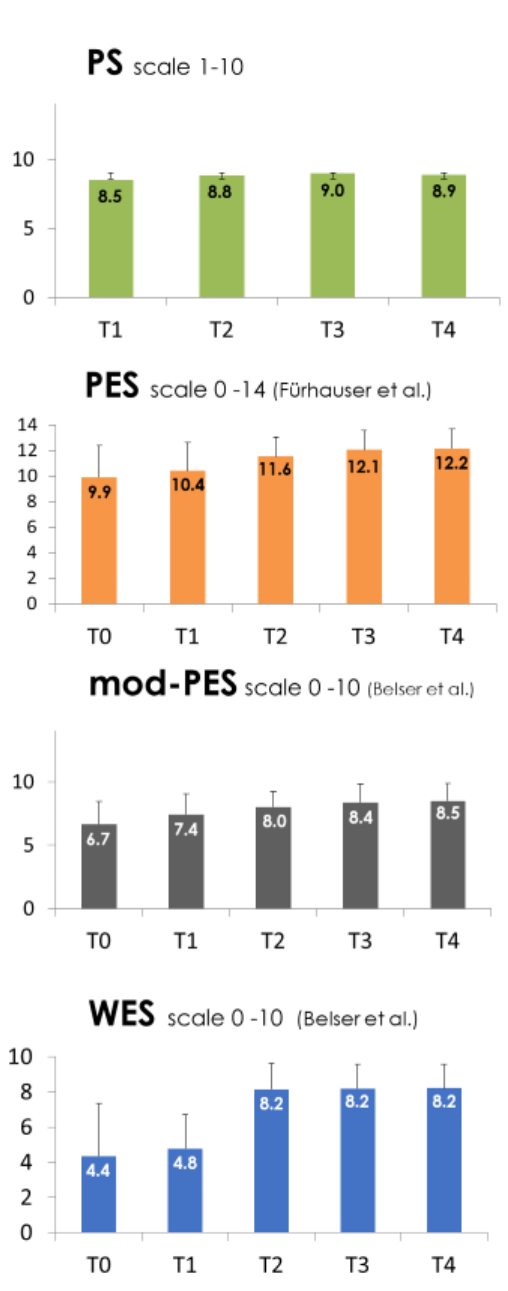
Figure 2. Mean and SD of patient satisfaction (PS), pink esthetic score (PES), modified pink esthetic score (modPES), and white esthetic outcome (WES) at different time points; preoperative (T0), 7–14 days after (T1), directly after crown placement (T2), 1 year postoperative (T3), and 3 years postoerative (T4) [15,16].